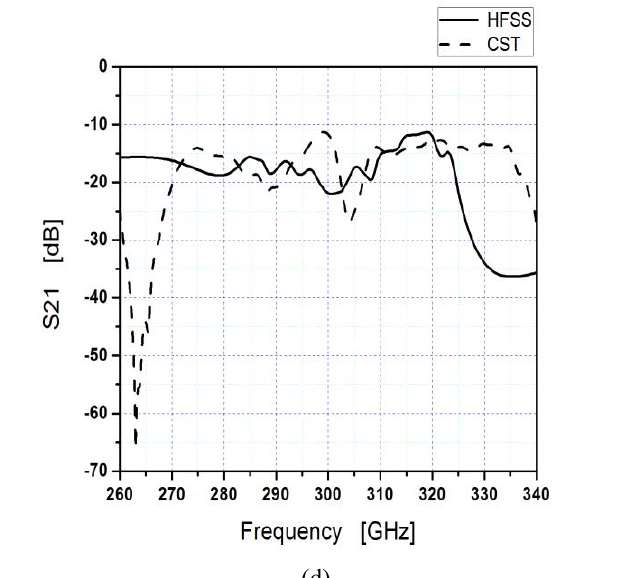
Figure 7: Reflection and transmission coefficients of the designed sinusoidally modulated leaky wave antennas.